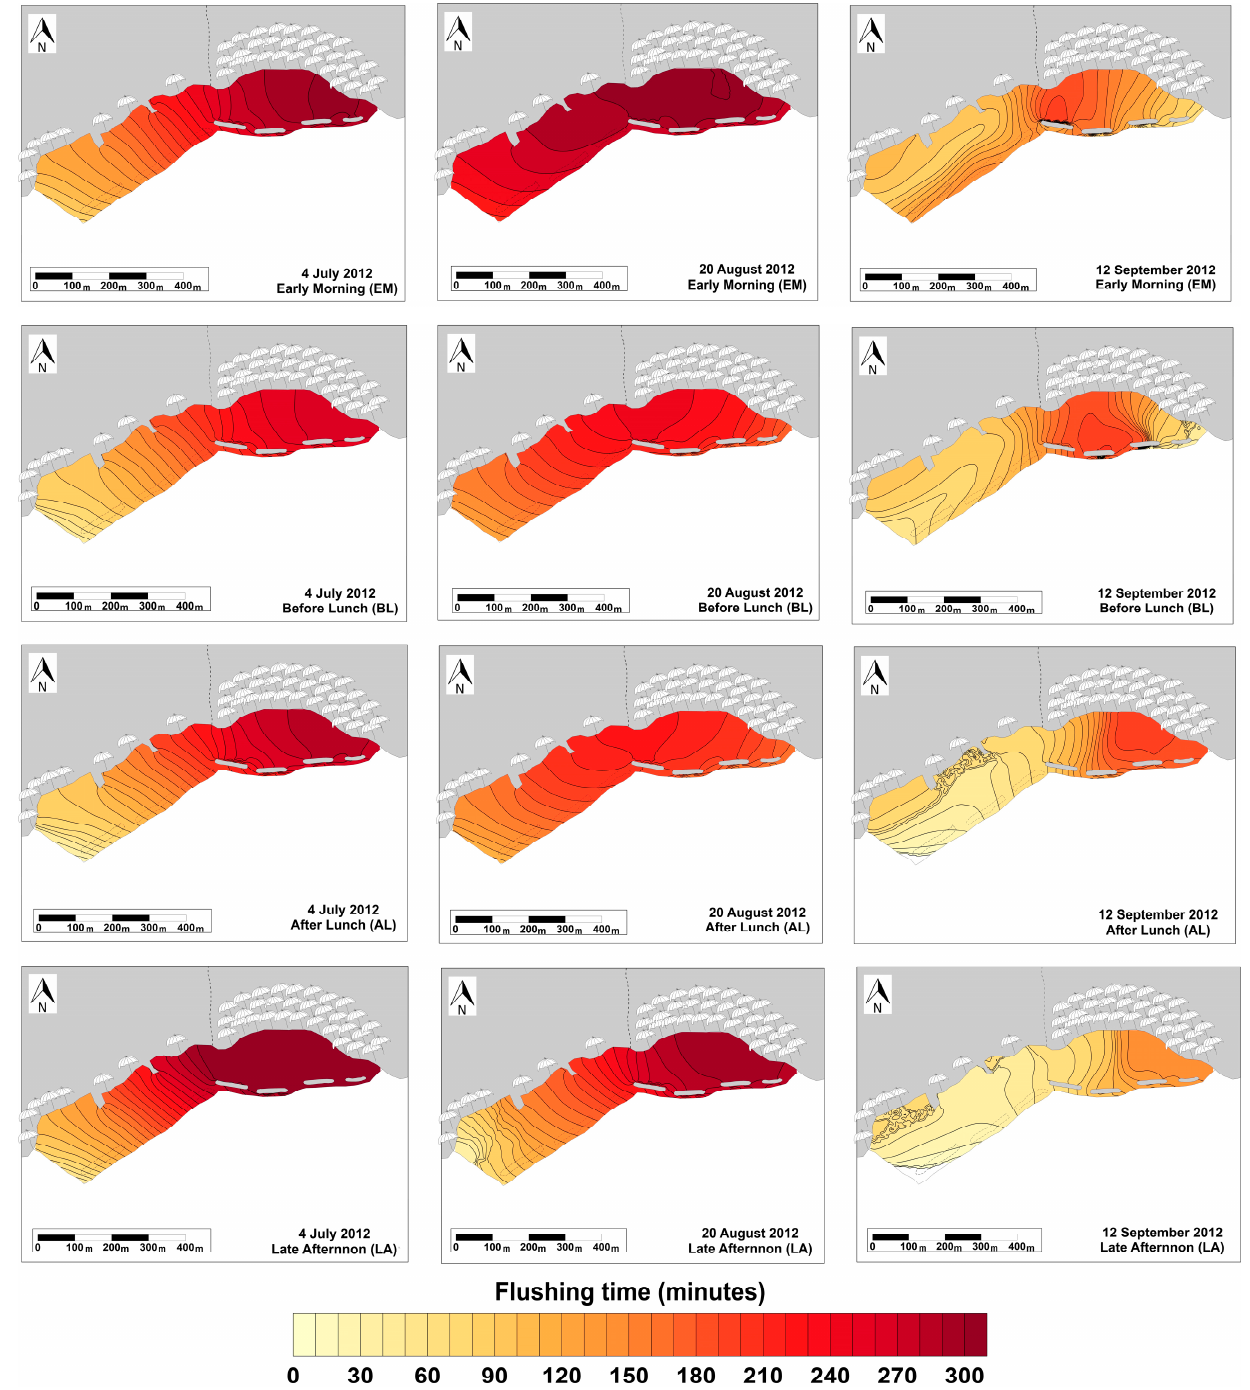
Figure 5. Flushing Time calculated on the viable E. coli (FT-V) within La Perla del Tirreno bathing area. FT-V is represented in the three sampling days of summer 2012 (July, August, September, in columns) and in the four daily periods (in rows).